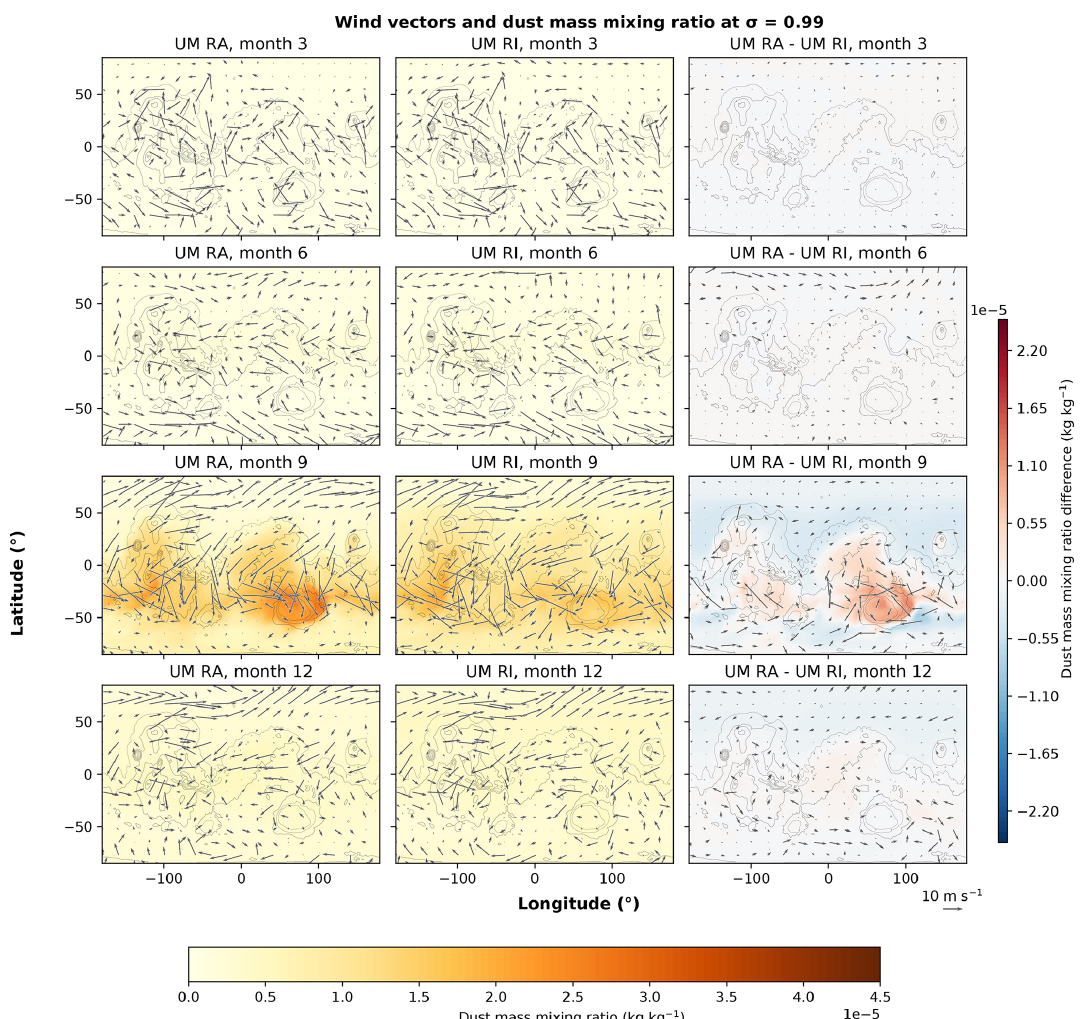
Figure A5. Dust mass mixing ratio (kgkg − 1 ) and horizontal wind speed (ms − 1 ) at σ = 0 . 99 across four seasons within the Martian year; each month is the average taken of all sols within that month (months according to Table A1). The RA dust scenario is shown on the left, the RI dust scenario in the centre and the differences between scenarios on the right. Colour scales in the left-hand and centre plots are matched across all months and between scenarios. The contours in the difference plots are matched across